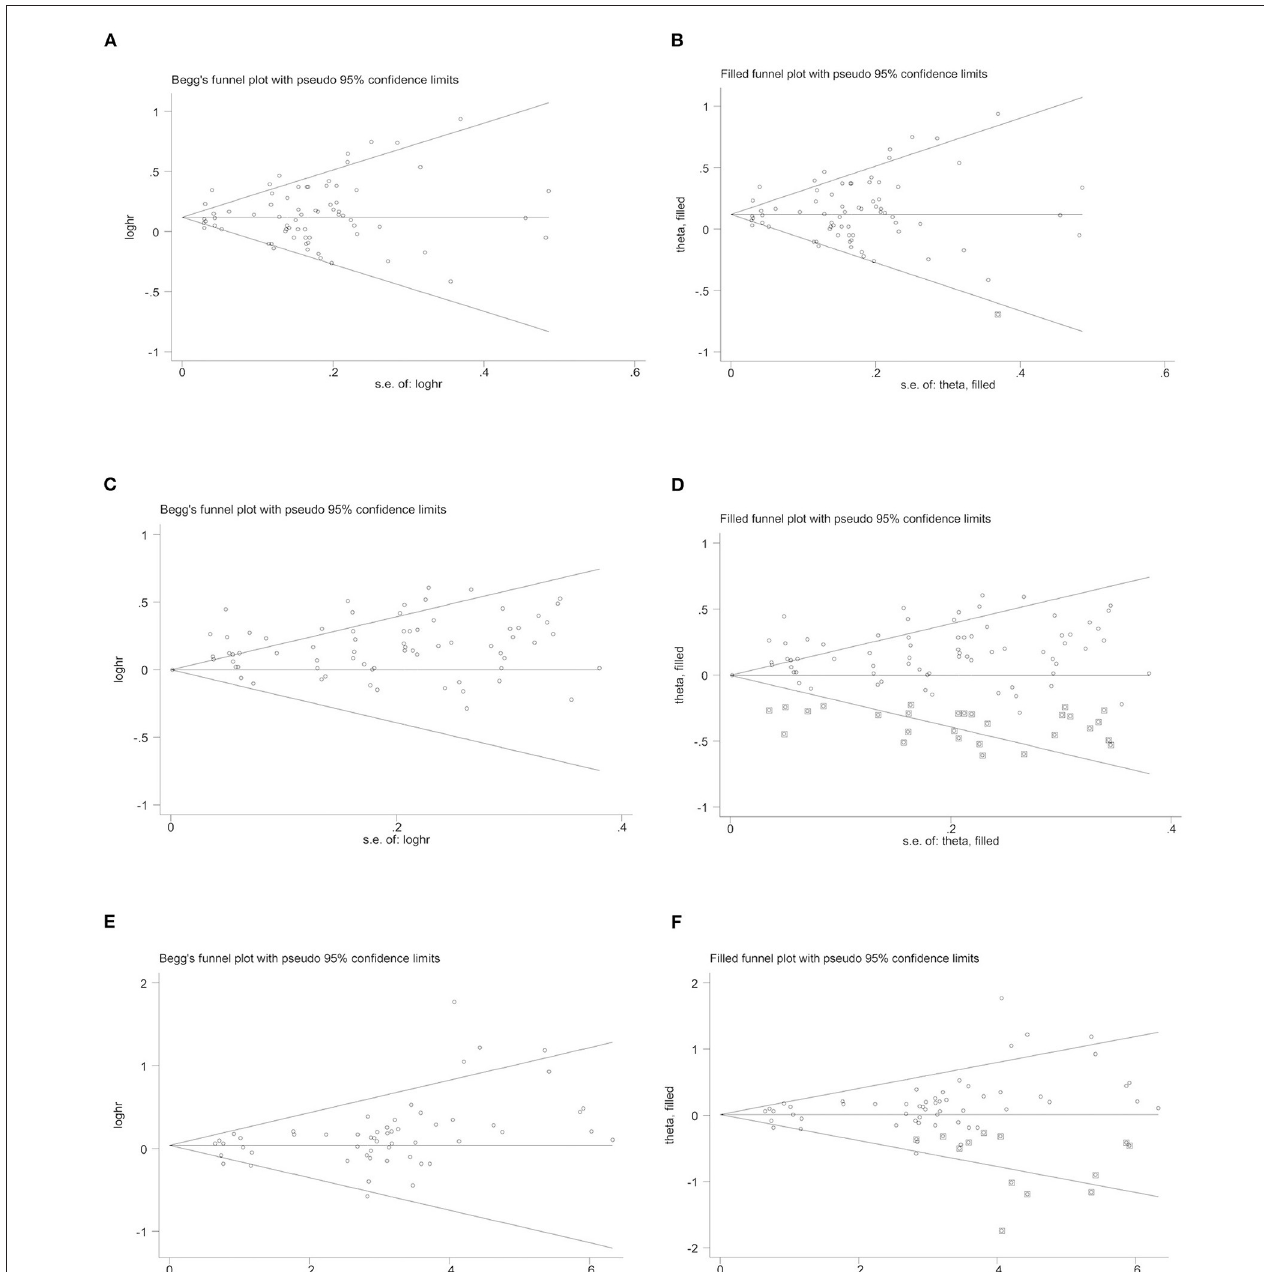
FIGURE 3 | Begg’s and filled funnel plots on the association of uric acid levels and risk of stroke. (A) Begg’s funnel plot and (B) Filled funnel plots: UA levels and total stroke. (C) Begg’s funnel plot and (D) Filled funnel plots: UA levels and ischemic stroke. (E) Begg’s funnel plot and (F) Filled funnel plots: UA levels and hemorrhagic